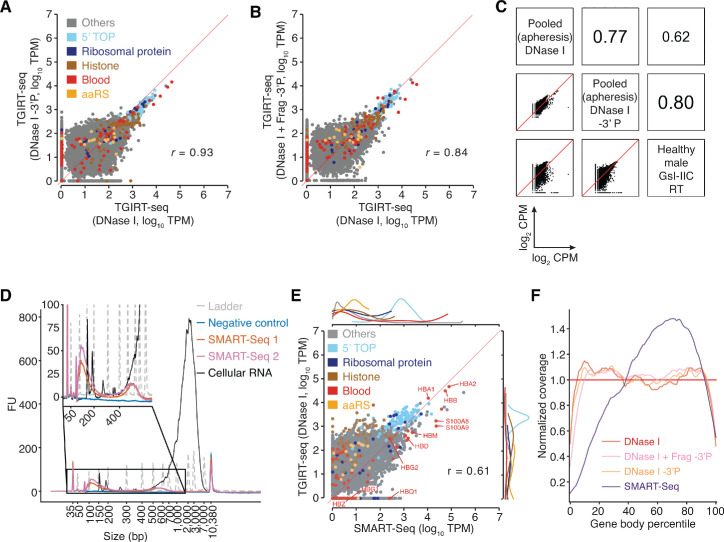
TGIRT-seq analysis of protein-coding gene transcripts in human plasma and comparison with SMART-Seq.(A, B) Scatter plots comparing protein-coding gene transcripts detected by TGIRT-seq in combined datasets for DNase I-treated plasma RNA without (n = 12) or with (n = 3) 3'-phosphate removal or chemical fragmentation followed by 3'-phosphate removal (n = 5). Reads aligned to protein-coding genes were extracted and quantified by Kallisto to obtain transcript-per-million (TPM) values, and average TPM values for each gene were plotted for each pairwise comparison. Each point represents one gene and is color-coded by type of encoded protein as indicated in the Figure. 5’ TOP includes those ribosomal proteins whose mRNAs have a 5' TOP sequence. The red line indicates identical TPM values for both methods. Pearson correlation coefficients are shown at the lower right. (C) Scatter plots comparing the relative abundances of protein-coding gene transcripts detected in DNase I-treated plasma RNA using the improved TGIRT-seq method in this work without (n = 12) or with (n = 3) 3'-phosphate removal with those detected previously by TGIRT-seq in DNase I-treated plasma RNA from a healthy male individual (n = 3; SRP064378, datasets 12–14) (Qin et al., 2016). CPMs for each gene were normalized to the total number of mapped reads in the dataset and log2 transformed for the comparisons. Spearman correlation coefficients are shown in sectors at the upper right. (D) Bioanalyzer traces of PCR-amplified cDNAs generated by SMART-Seq according to manufacturer’s protocol. Samples were analyzed using an Agilent 2100 Bioanalyzer with a High Sensitivity DNA kit. Traces are color-coded by sample type as shown in the Figure, with ‘Ladder’ (dashed gray lines) indicating the DNA ladder supplied with the High Sensitivity DNA kit. The negative control was a SMART-Seq library prepared with water as input, and the cellular RNA control was the positive control RNA supplied with the SMART-Seq kit. SMART-Seq 1 and 2 indicate double-stranded DNAs generated by using the SMART-Seq kit from different samples of DNase I-treated plasma RNA. FU, fluorescence units. (E) Scatter plot comparing protein-coding gene transcripts detected in plasma by TGIRT-seq and SMART-Seq. Reads assigned to protein-coding genes transcripts (0.28 million reads for TGIRT-seq and 2.6 million reads for SMART-Seq) were extracted from combined datasets obtained from DNase I-treated plasma RNA (n = 12 for TGIRT-seq and n = 4 for SMART-Seq) and quantified by Kallisto. The scatter plots compare average TPM values for protein-coding gene transcripts with each point representing one gene, color-coded by the type of encoded protein (see above). The marginal distributions of different color-coded mRNA species in the scatter plot are shown above for SMART-Seq and to the right for TGIRT-seq. The red line indicates identical TPM values for both methods. The Pearson correlation coefficient (r) is indicated at the bottom right. (F) Normalized 5’- to 3’-gene body coverage for protein-coding gene transcripts detected in plasma by TGIRT-seq and SMART-Seq. Gene body coverage was computed by Picard tools (Broad Institute) using the genomic alignment files generated by Kallisto. The plots show normalized gene coverage versus normalized gene length for all protein-coding transcripts in the indicated datasets color-coded as indicated in the Figure. The red horizontal line at y = 1 indicates perfectly uniform 5' to 3' coverage.